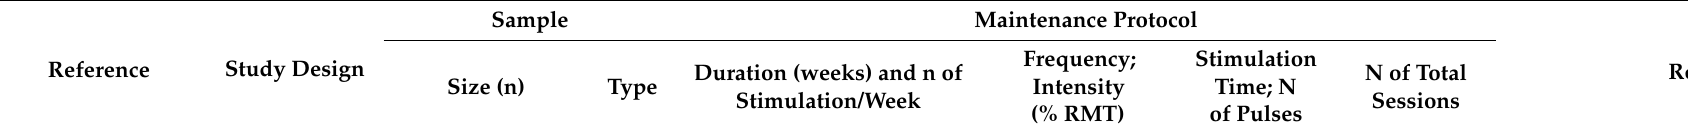
Table 2. Maintenance protocols sorted by study design and alphabetical